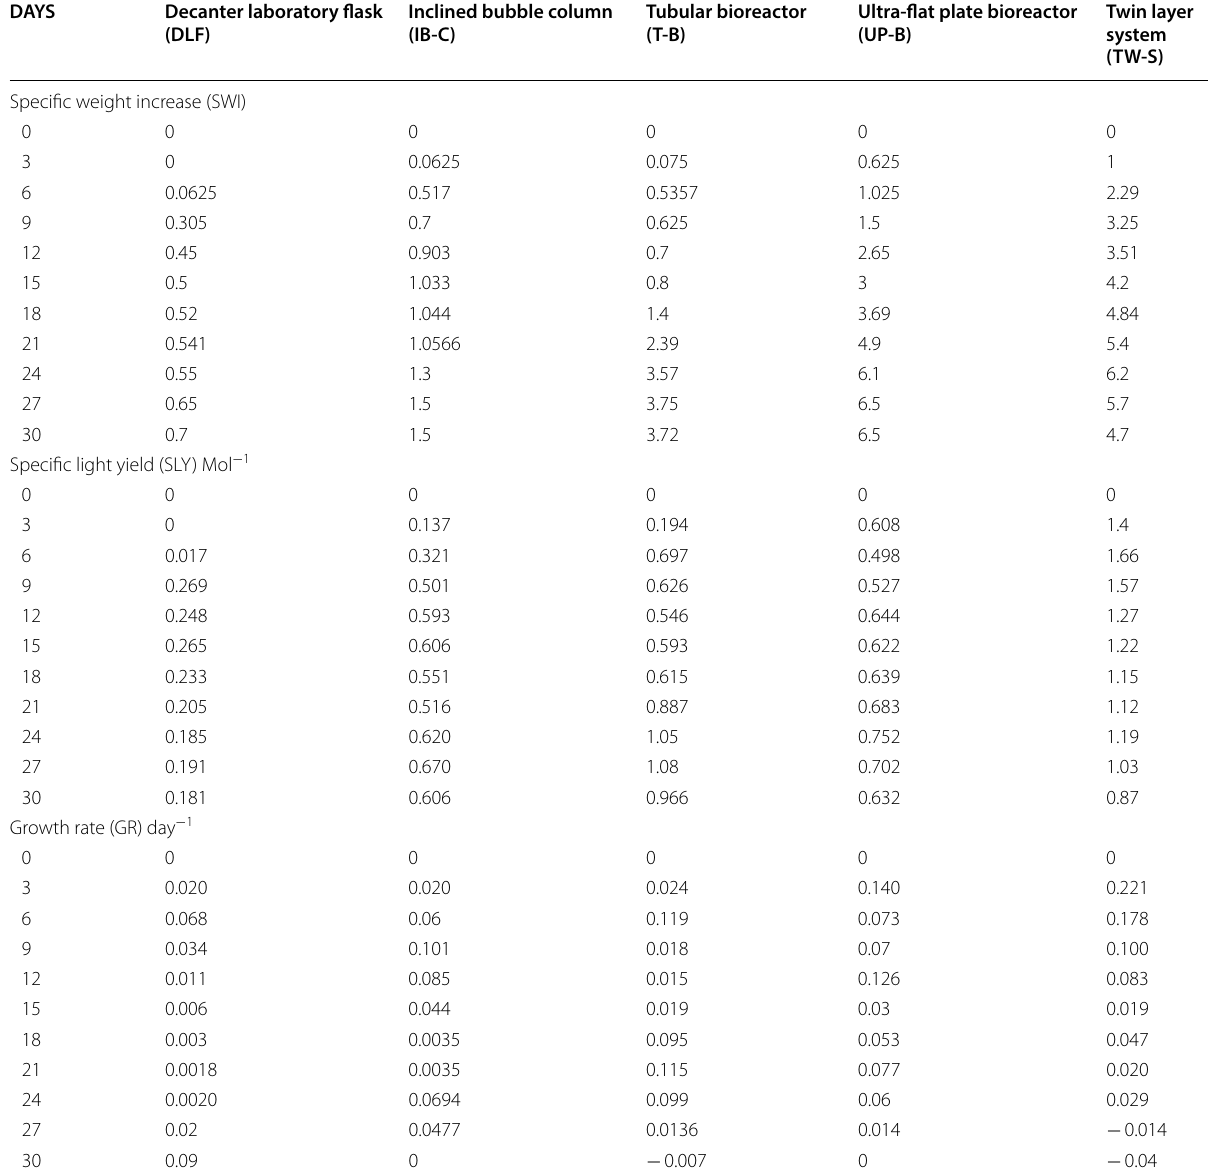
Table 1 Growth parameters of microalgae in different